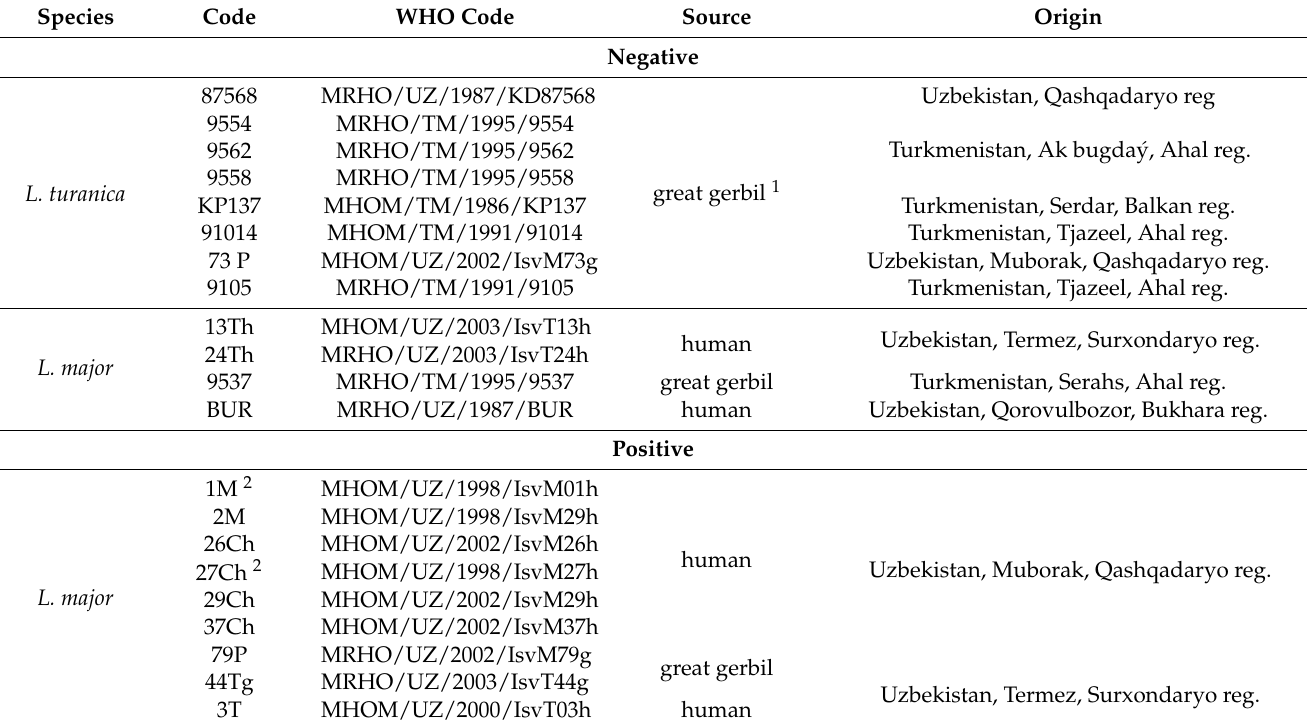
Table 1. Strains of Leishmania spp. investigated in this